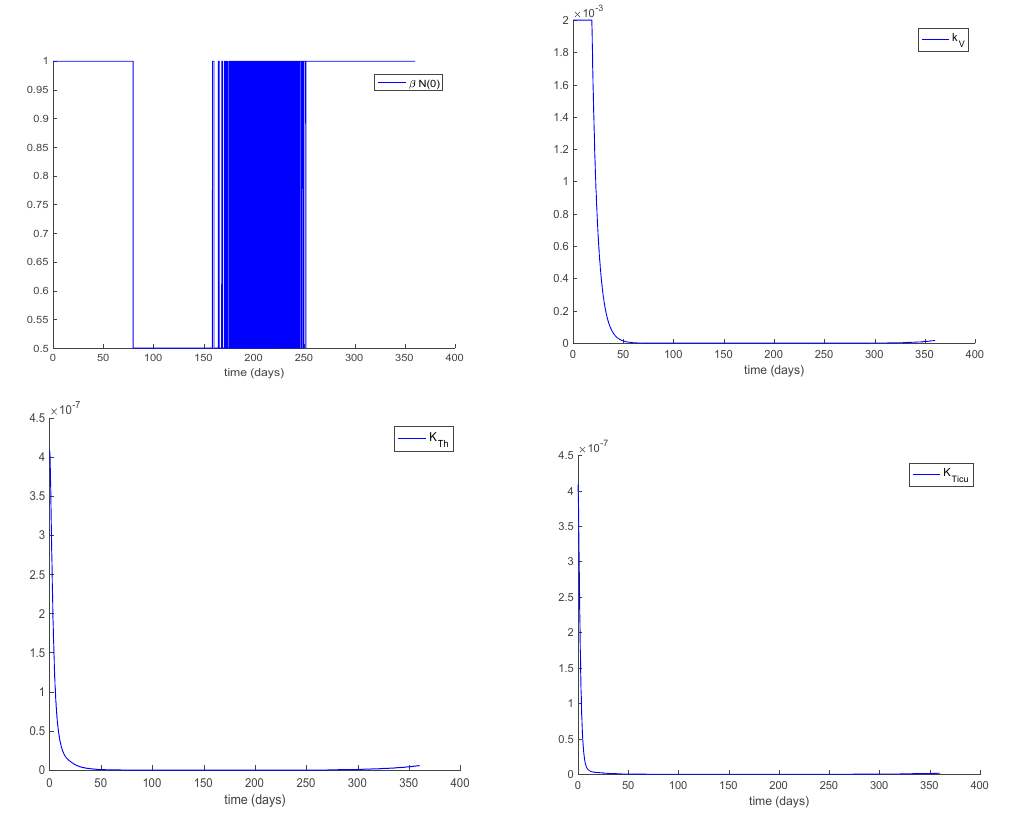
Figure 12. Control gains when Programme 6 is employed.